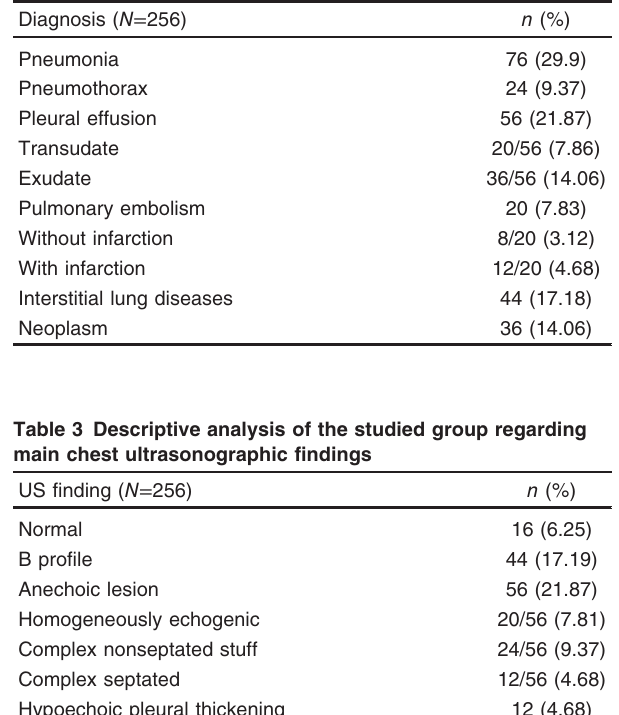
Table 2 Descriptive analysis of the studied group as regards main chest radiographic findings